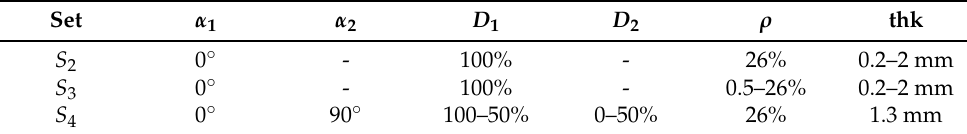
Table 2. Optical properties of the simulated in-silico media.